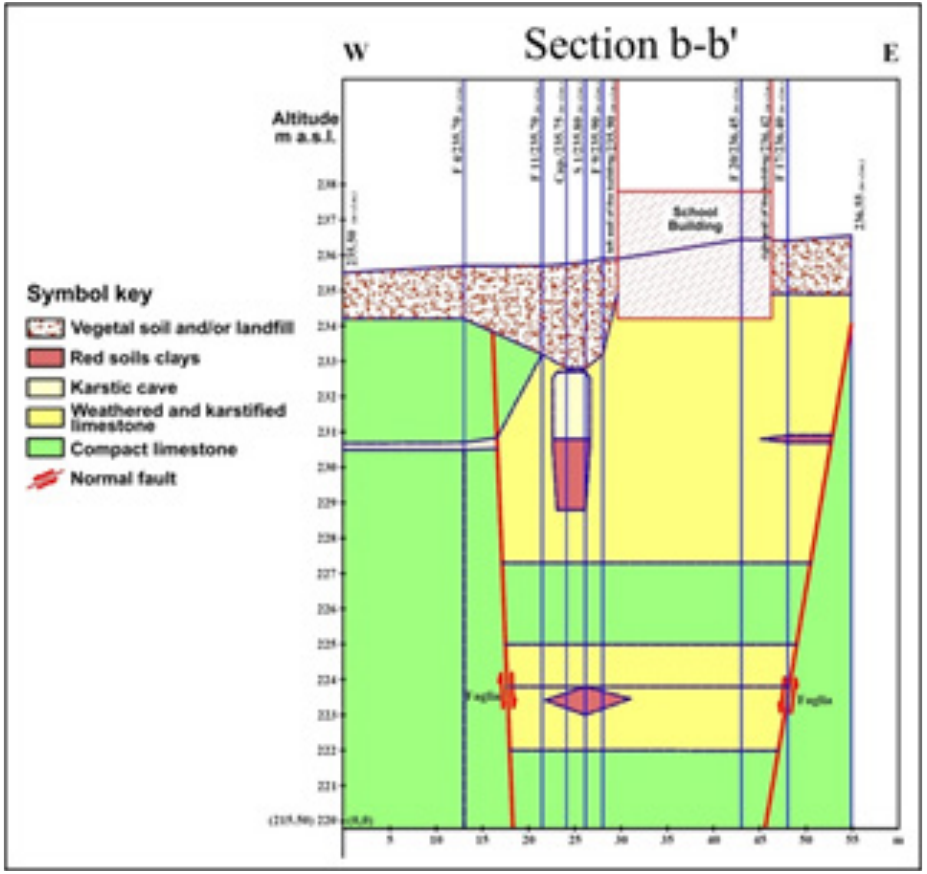
Figure 7: Geomechanical model section used for the LSR evaluation; the upper karst cave has a height of L= 4.00 m and a width of D= 3.00